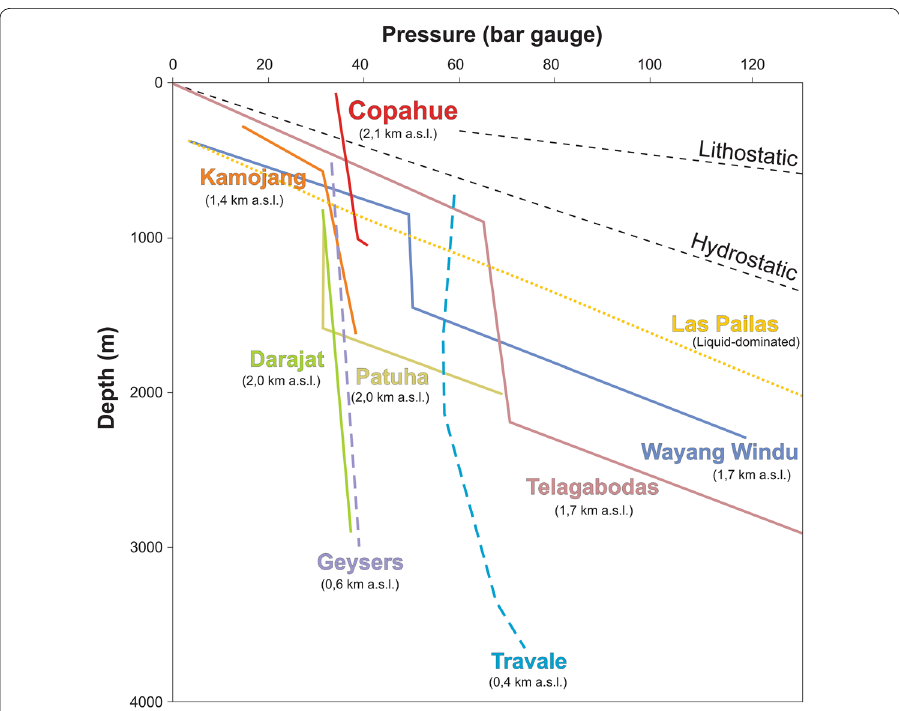
Fig. 2 Stable downhole pressure profiles for the vapor-dominated reservoirs around the world (JICA 1992; Allis and Shook 1999; Layman and Soemarinda 2003; Bogie et al. 2008). Volcano-hosted reservoirs (colored continuous lines); plutonic-hosted vapor-dominated reservoirs (dashed lines). Las Pailas liquid-dominated reservoir, and lithostatic and hydrostatic profiles were included as a